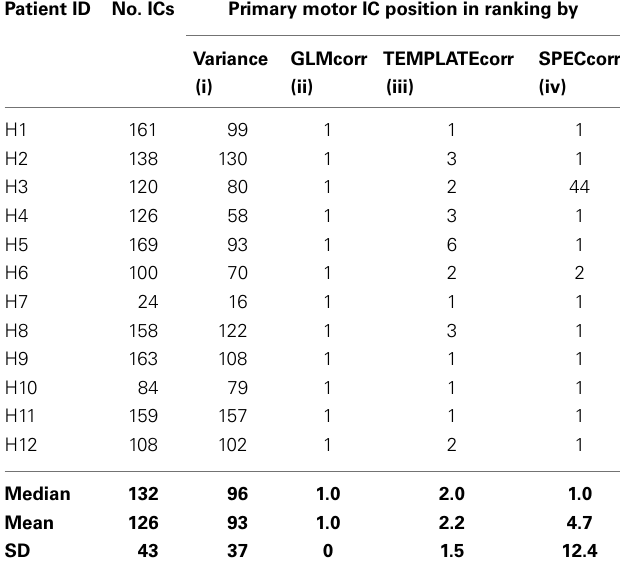
Table 5 | Summary of the total number of components identified in the Hand group (No. ICs) and ranking of the primary motor component in the list by (i) percentage of variance explained (MELODIC default) (ii) correlation between IC spatial map and GLM t-map (iii) correlation between IC spatial map and a precentral gyrus template (iv) correlation between frequency spectrum of model time course and frequency spectrum of IC.